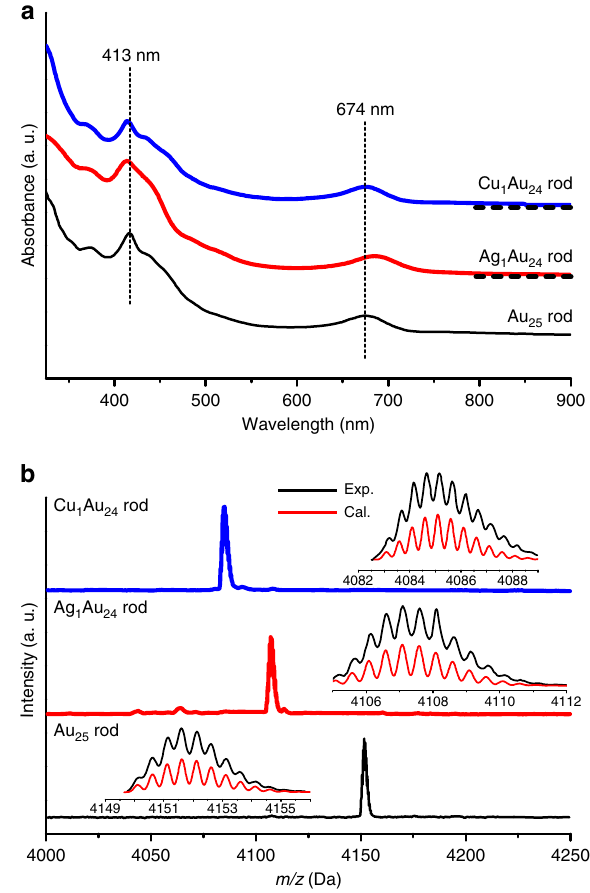
Fig. 2 UV – Vis and ESI-MS spectra of homo-gold and doped MAu 24 nanoclusters. a UV – Vis spectra of homo-gold [Au 25 (PPh 3 ) 10 (PET) 5 Cl 2 ] 2+ (black line), single Ag doped [Ag 1 Au 24 (PPh 3 ) 10 (PET) 5 Cl 2 ] 2+ (red line), and single Cu doped [Cu 1 Au 24 (PPh 3 ) 10 (PET) 5 Cl 2 ] 2+ (blue line); b Positive mode ESI-MS spectra of homo-gold [Au